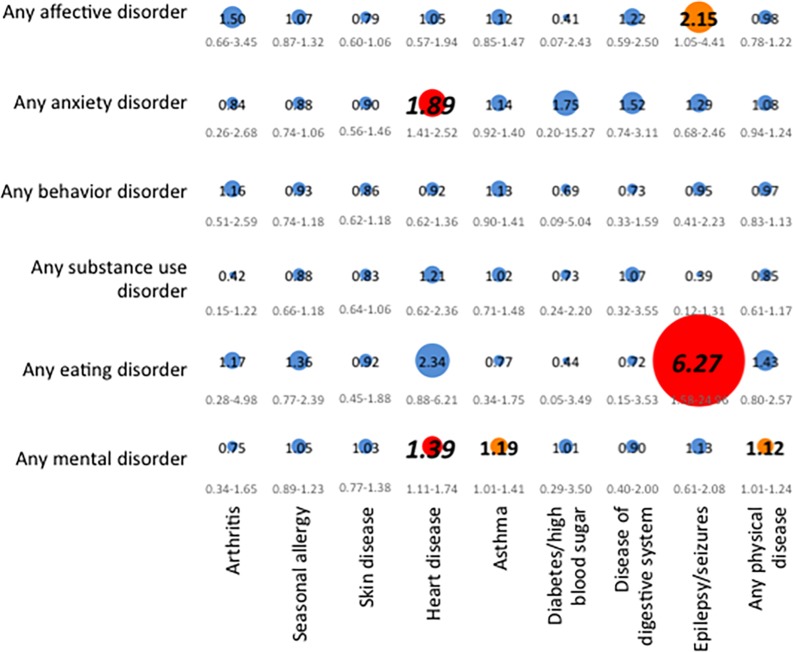
Adjusted discrete-time proportional hazard models estimating the temporal associations of physical diseases predicting subsequent mental disorders.Note: We based our analyses on completer sample sizes* of the total study sample (N = 6483), and adjusted for sociodemographic variables shown in Table 1. The strength of the associations (hazard ratios (HR) is illustrated by the circle diameter, given in the circles, with 95% confidence intervals, given below the circles). Blue color of the circle (and HRs provided in small standard type font) represent p≥0.05 in the total study sample; orange color of the circle and HRs provided in medium-sized bold type font represent p<0.05 in the total study sample and in less than two independent subsamples; red color of the circle and HRs provided in large bold and italic type font represent p<0.05 in the total study sample and in at least two independent subsamples. * Due to missing information on physical diseases from adolescent self-report, sizes of the completer samples are as follows: arthritis: n = 6473, seasonal allergy: n = 6475, skin disease: n = 6479, heart disease: n = 6481, asthma: n = 6477, diabetes/high blood sugar: n = 6481, disease of the digestive system: n = 6481, epilepsy or seizures: n = 6481, any physical disease: n = 6469.